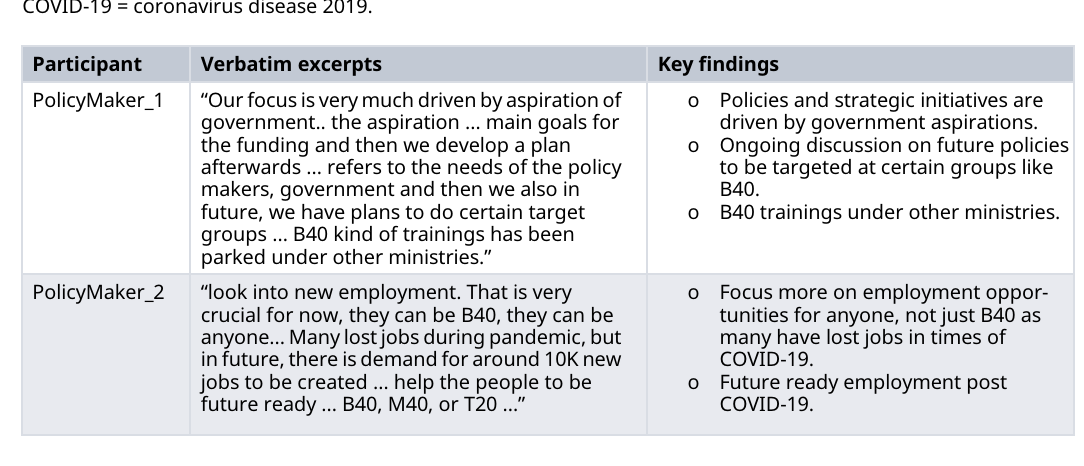
Table 7. Selected excerpts on strategic plans to maximise benefits of B40 youth trainings. COVID-19 = coronavirus disease 2019.